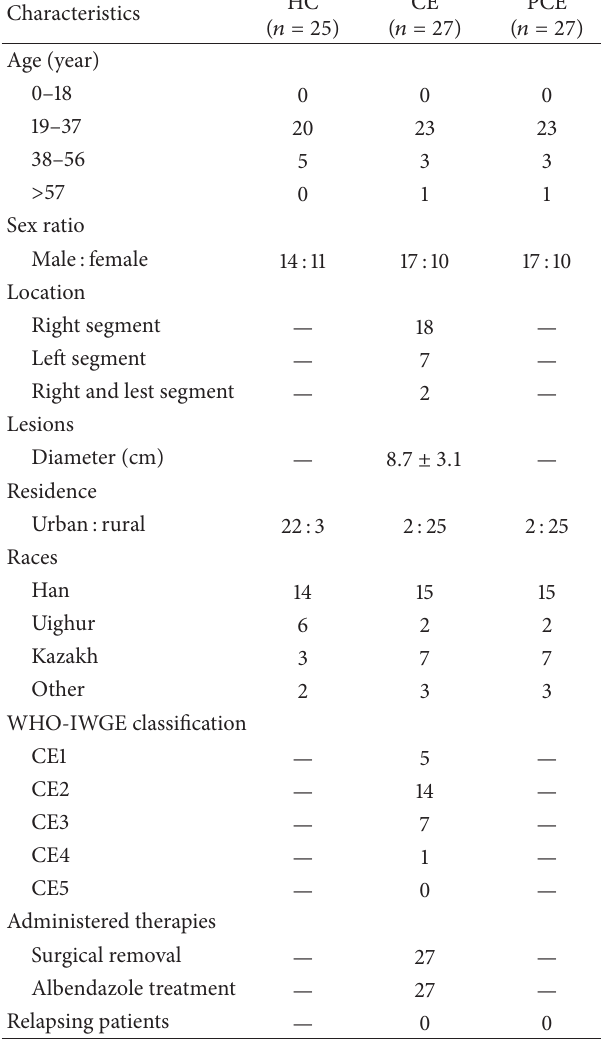
Table 1: Clinical data of the healthy control (HC) and patients with liver echinococcosis before and after